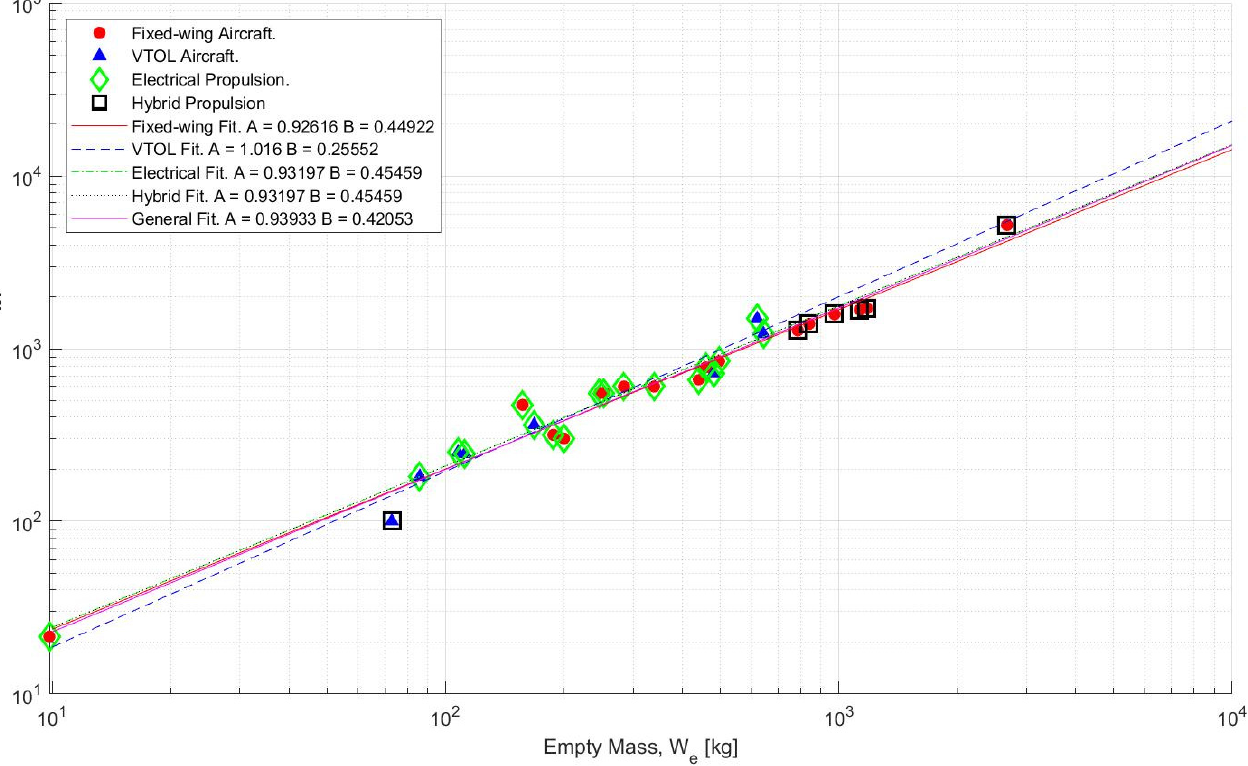
Figure 13. Mass relationship from literature